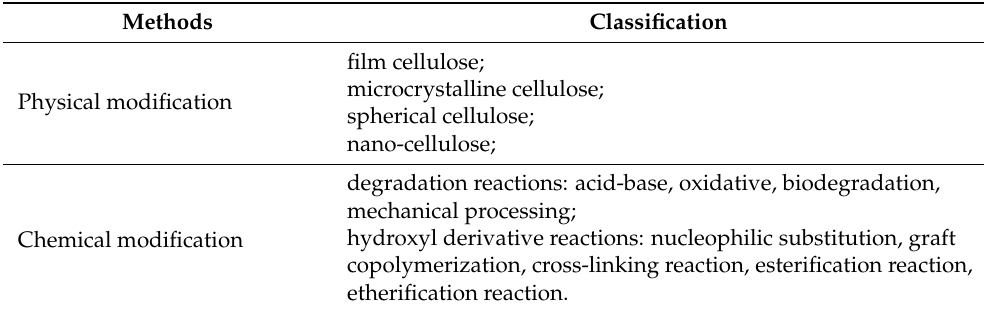
Table 2. Modification method and classification of cellulose